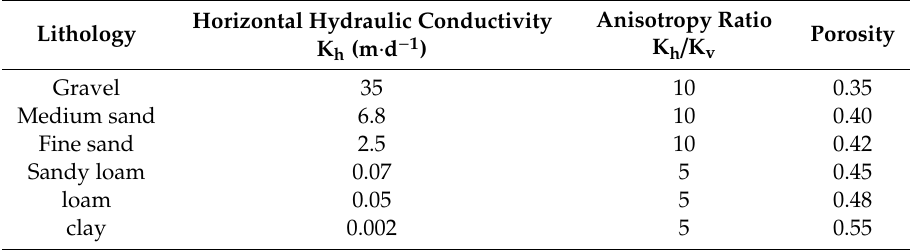
Table 1. Estimated parameters of di ff erent